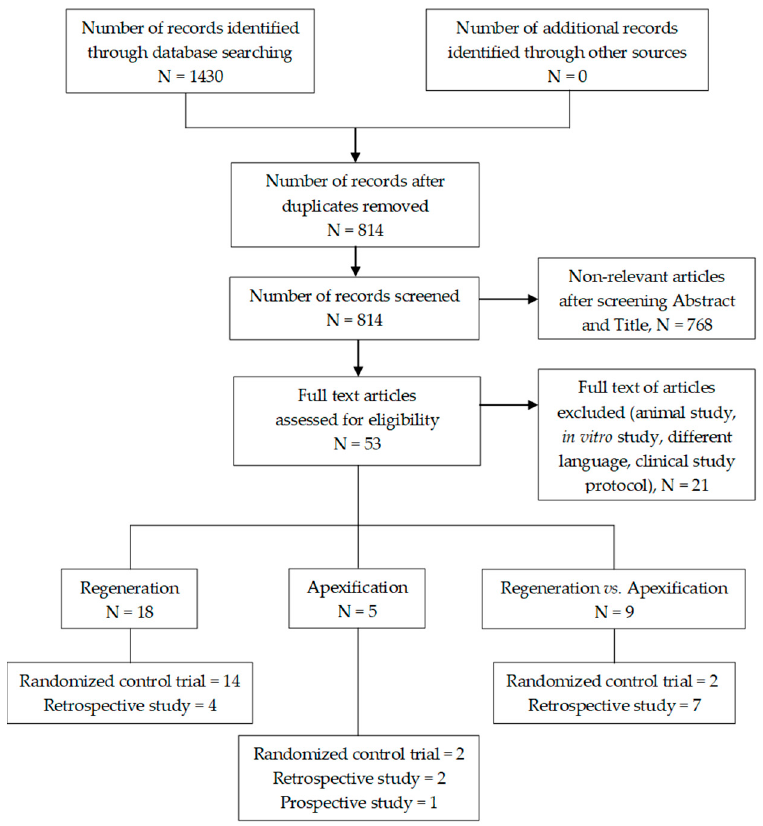
Figure 1. PRISMA 2020 flow diagram for systematic review that includes searches of databases.